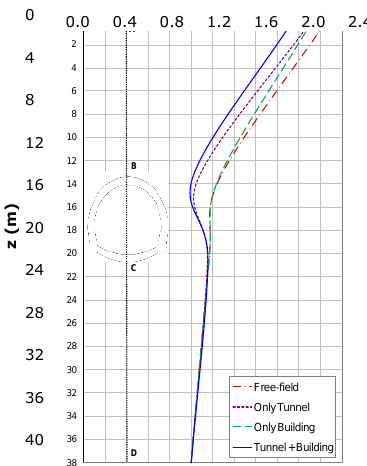
Figure 4. Comparison among amplification ratio profiles achieved for different configurations of the analyzed system (after [20]).